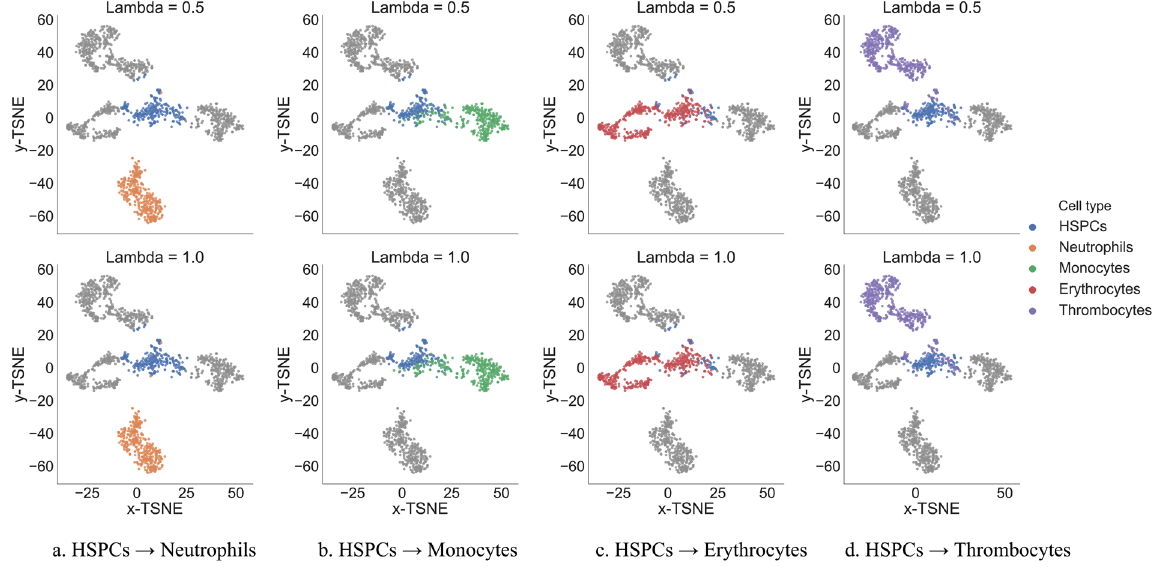
Figure 3. Results obtained after performing cell perturbations. We show in colour the cells of interested for each subfigure and in grey the rest of the cells. Each subfigure indicates how many of the HSPCs were converted into each type of mature blood cell after performing perturbations to the latent representations of DiffVAE. Notice that increasing the shifting parameter λ in the perturbations will result in more cells to be changed.